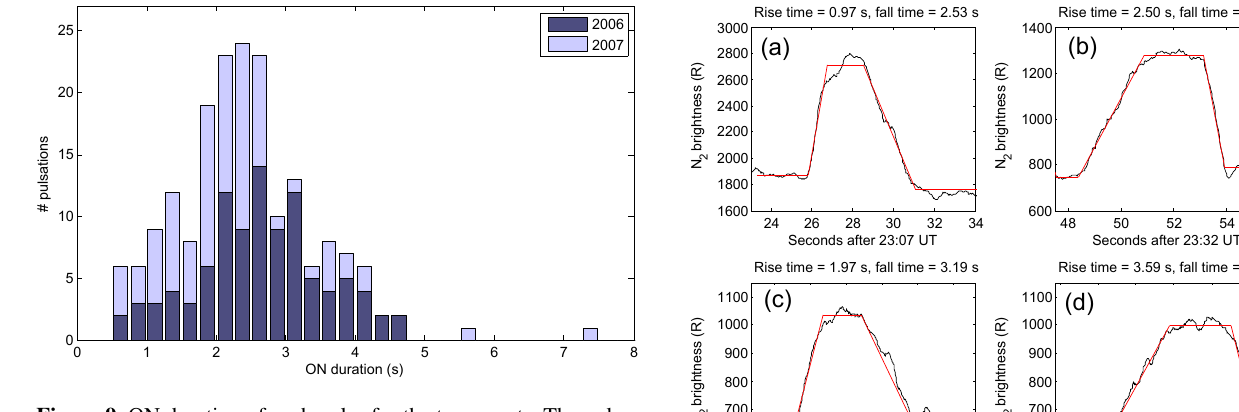
Figure 9. ON duration of each pulse for the two events. The pulsa- tions during the 2006 event are on average longer than those during the 2007 event.